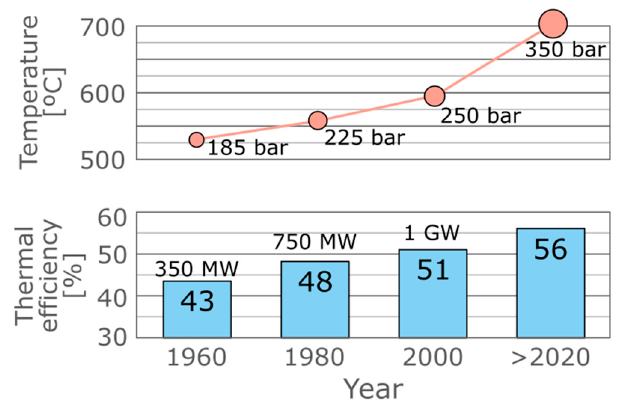
Figure 11. Evolution of technical parameters of steam power plant turbines from 1960 (data source: [24]).